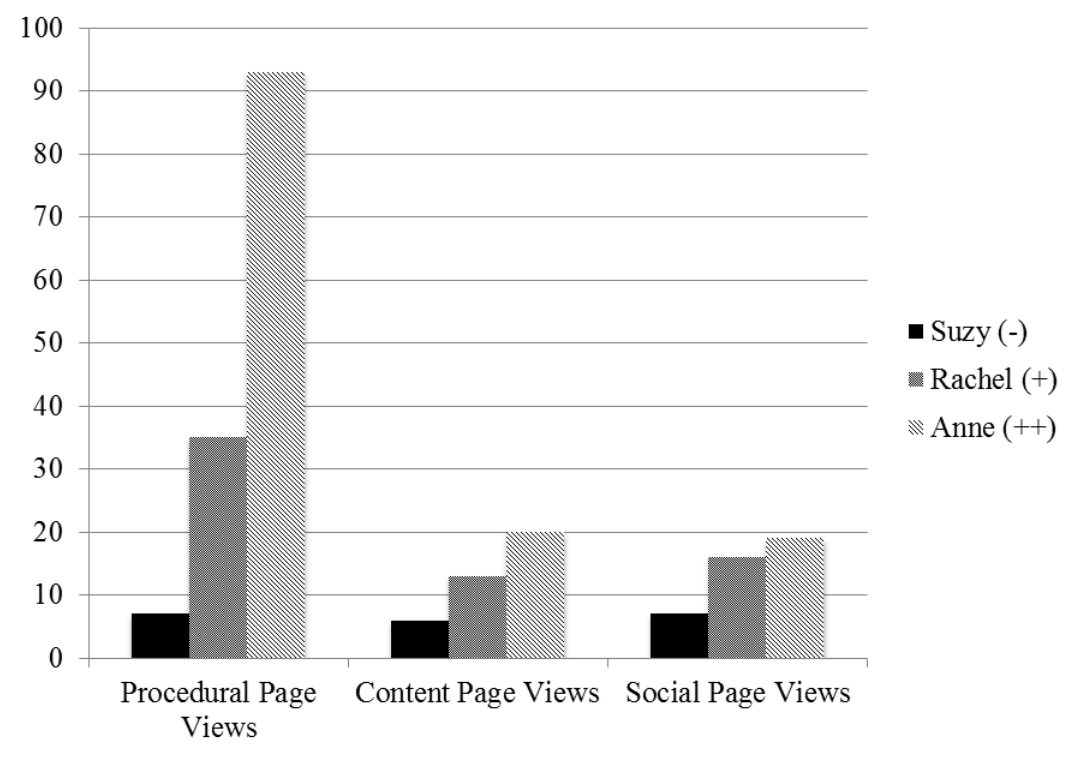
Figure 8. Number of Procedural, Content, and Social Page Views for First Week of